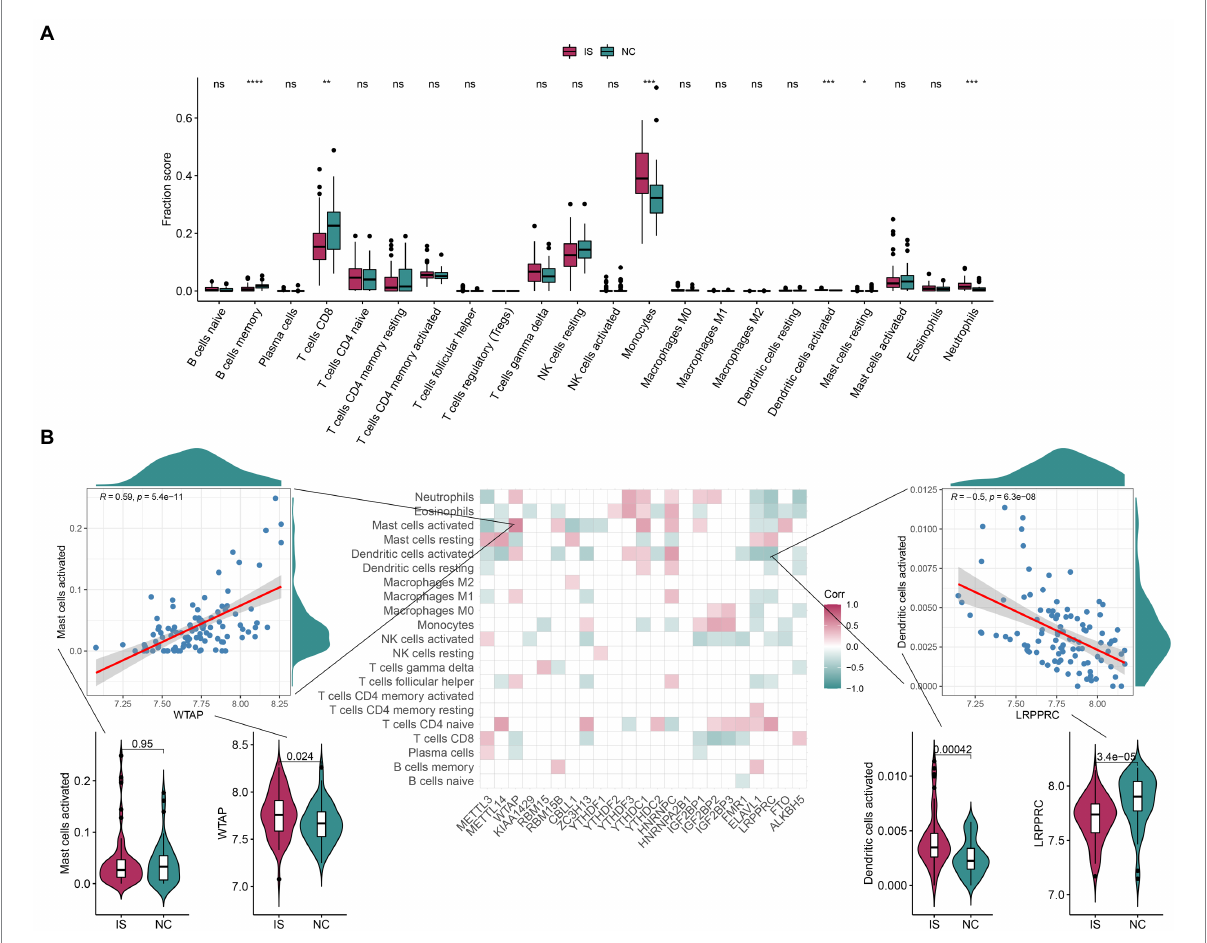
FIGURE 4 The correlation between infiltrating immune cells and m6A regulators. (A) The boxplot of immune infiltrating cell content contains 22 immune cells, each of which is shown in green in the NC group and red in the IS group. Compared with the NC group, the content of CD8 in T cells was significantly lower and the content of Monocytes was significantly higher in IS. (B) Correlation plots show the correlation between the degree of immune microenvironment infiltration and each of the m6A regulators. The positive correlation between Mast cells activated and WTAP was high, at 0.59; the negative correlation between Dendritic cells activated and LRPPRC was high, at-0.5. IS, ischemic stroke. NC, normal. ns: value of p ≥ 0.05; *: value of p < 0.05; **: value of p < 0.01; ***: value of p < 0.001; ****: value of p <